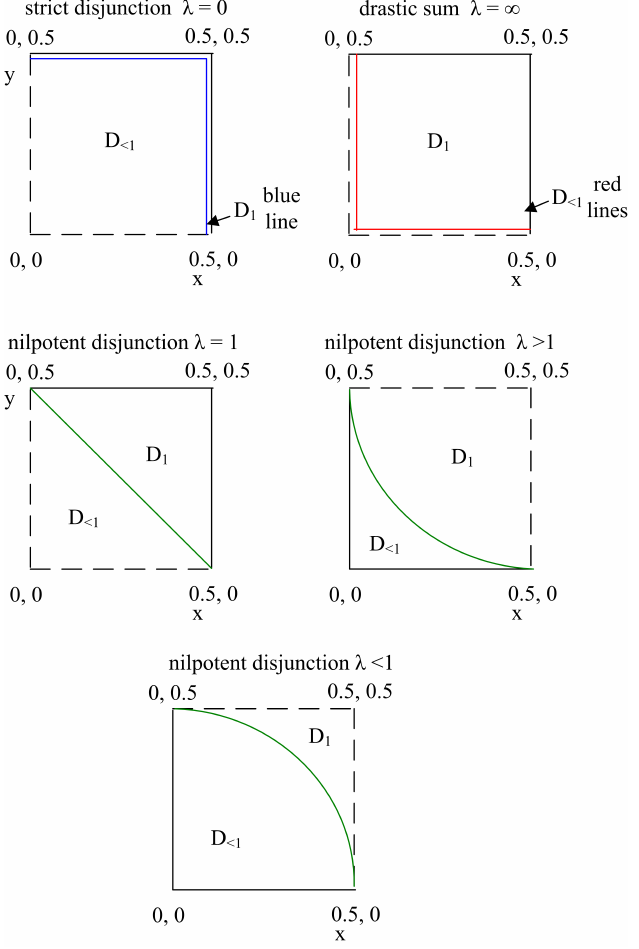
Figure 2. Learning of the disjunctive part of classification by ordinal sums for class no